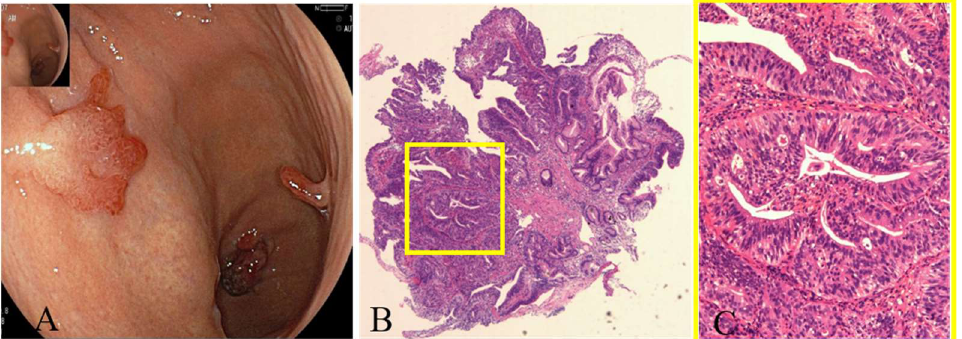
Figure 6. Malignant transformation of a GHP arising from the background of AMAG. ( A ) EGD showing multiple gastric hyperplastic polyps, ( B , C ) pathology revealing moderately differentiated adenocarcinoma at the tip of one of the GHPs (yellow square, HE stain; ( B ) ×4; and ( C ) ×20). Case 3: A 65-year-old female patient who had Hashimoto’s disease in the past for 5